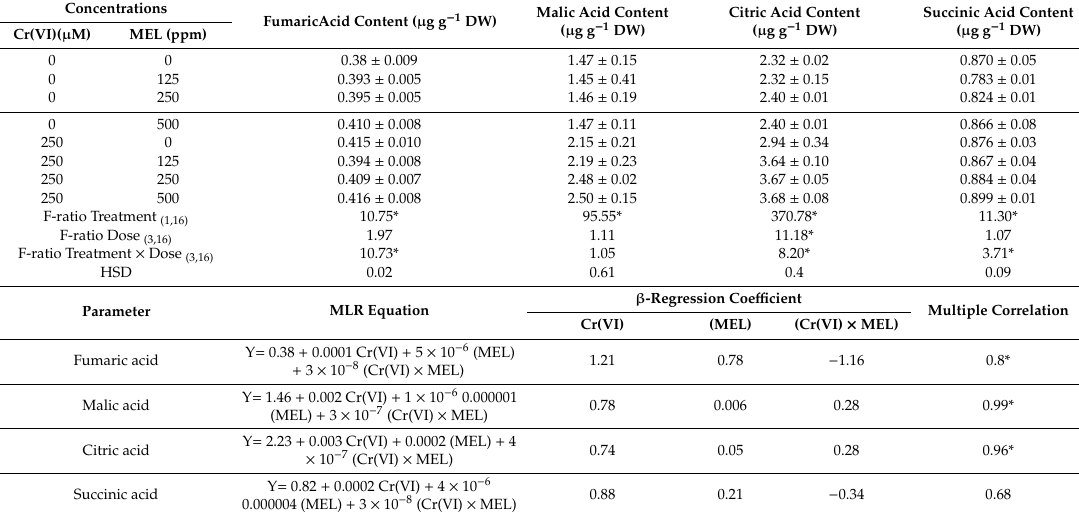
Table 12. E ff ect of Cr(VI), di ff erent concentrations of methanol extract of Rhododendron arboreum leaves (MEL), and their combinations on fumaric acid, malic acid, citric acid, and succinic acid content in 7-day-old Vigna radiata seedlings. The values are the means of three replicates ± SD. (standard deviation). Tukeys test performed and significance checked at * p ≤ 0.05. The F ratio is the term in which ANOVA is represented; Cr(VI) = Dose, MEL treatments = Treatment and combination of Cr(VI) and MEL = Dose ×